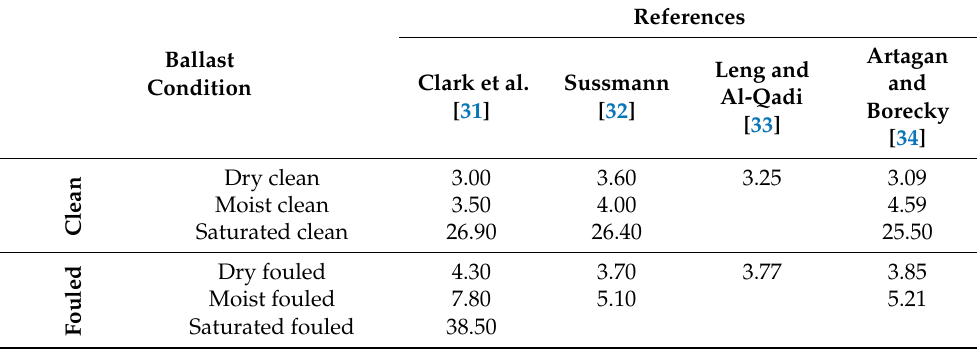
Table 1. Relative dielectric permittivity (RDP) values of granite railway ballast under several different conditions in published literature.